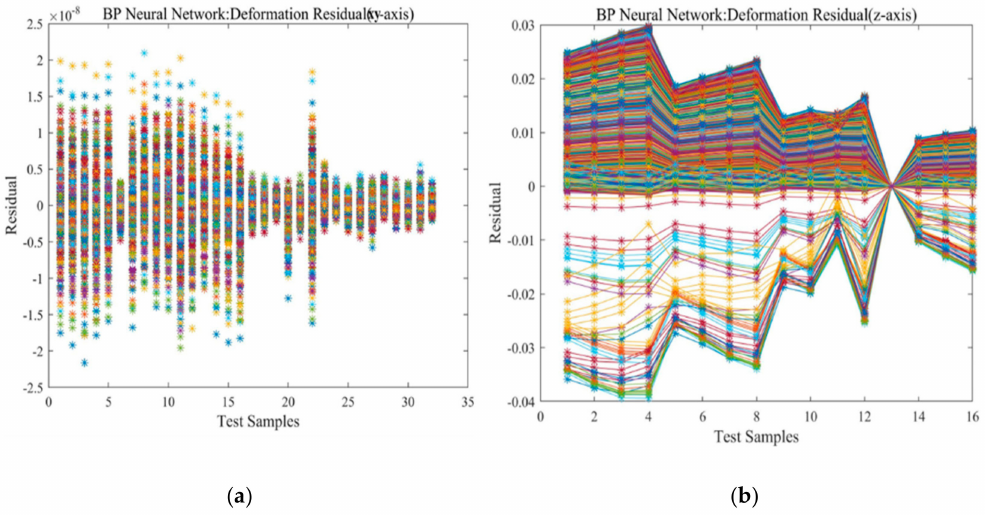
Figure 11. Residuals of the mode: ( a ) the x- and y-axis; ( b ) the